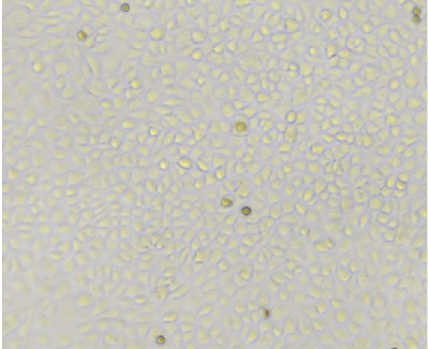
Figure 1: The EPCs were cultured for 14 days were arranged like